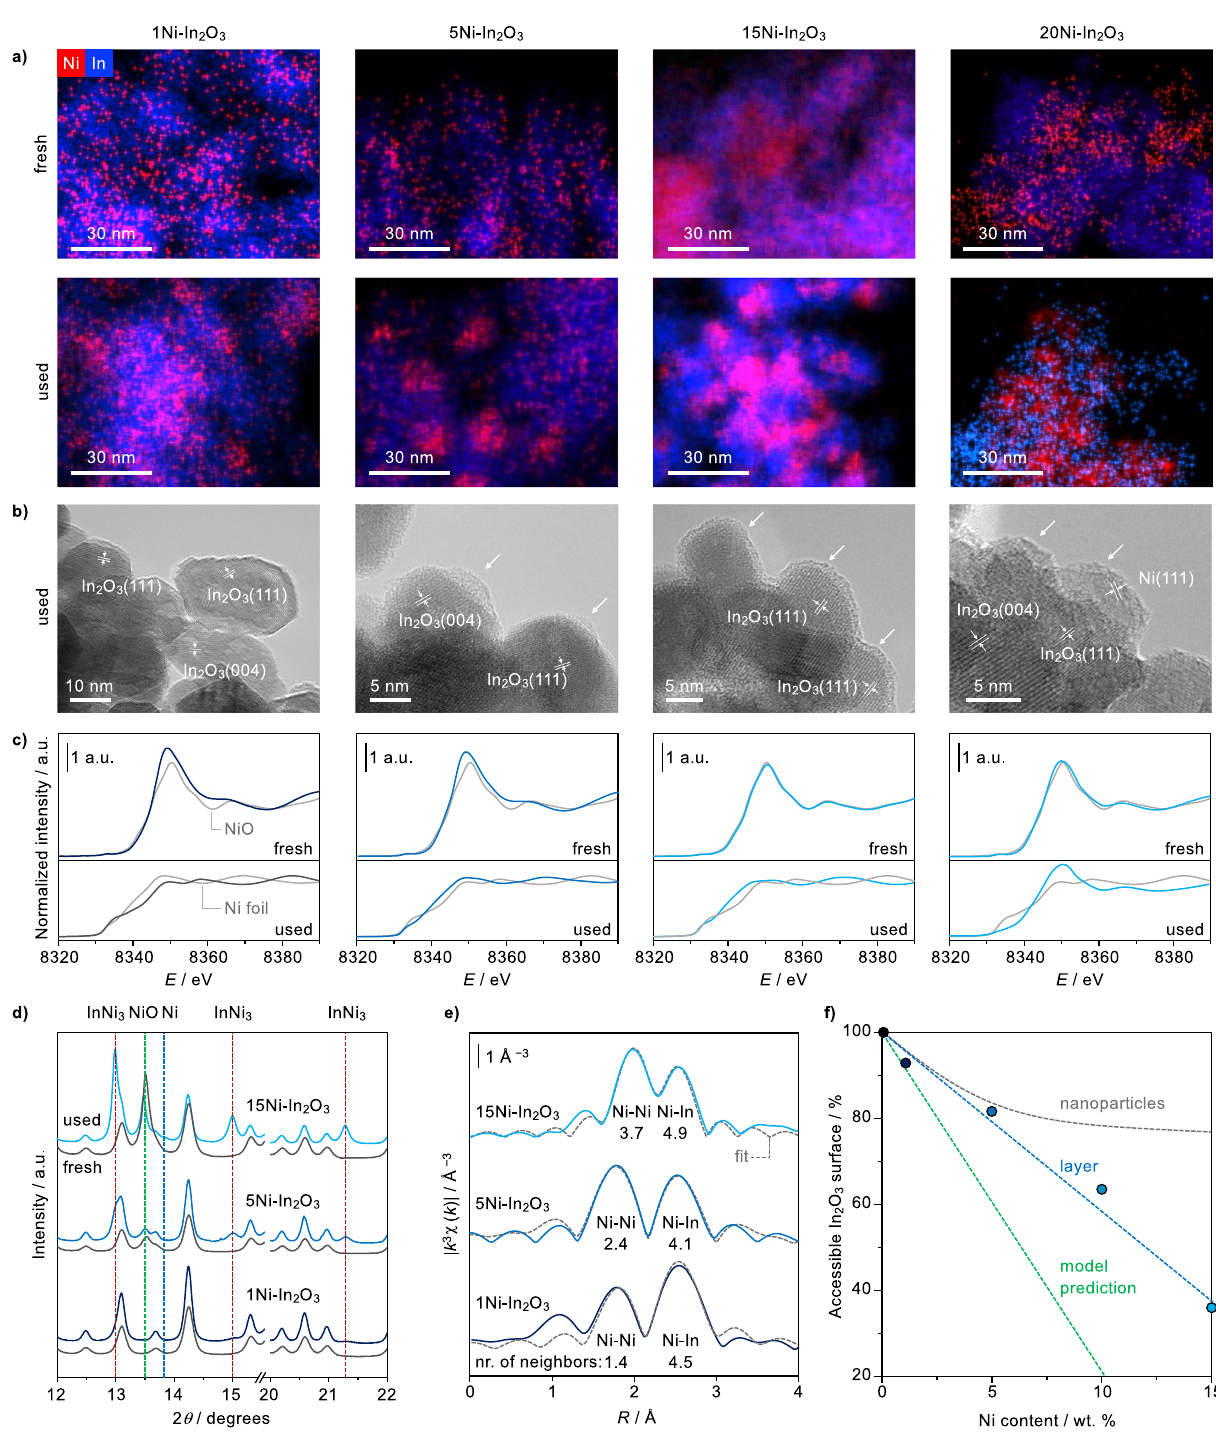
Fig. 3 Structural and electronic elucidation of nickel-promoted In 2 O 3 catalysts. a STEM-EDX maps of Ni-In 2 O 3 catalysts containing 1 – 20 wt.% Ni in fresh and used forms. b HRTEM images, with phases identi fi ed by fringe analysis and features of interest indicated, and c k -weighted Ni K-edge XANES, with spectra of NiO and metallic nickel serving as references, for the same used catalysts. d XRD patterns collected in monochromatic light and e EXAFS with model fi t and an indication of neighbors ’ number along a speci fi c scattering path for selected fresh and used samples. f Percentage of In 2 O 3 surface not covered by nickel as a function of the nominal nickel content, determined by volumetric CO 2 chemisorption. The qualitative trend respective to nanoparticle formation and the coverage predicted by DFT is indicated. a.u. = arbitrary High-resolution X-ray diffraction (XRD, Fig. 3d, Supplemen- nickel, respectively, in good agreement with the microscopy tary Fig. 4) measured in monochromatic light ( λ = 0.49292 Å) analyses. Alloy formation with indium shall be key to anchor the indicated that NiO, present in the fresh materials, reduced indeed intermetallic phase strongly to the catalyst surface, preventing forming InNi 3 alloys. Their average crystal size is <1, 2.7 ± 0.7, signi fi cant sintering. Only for 15Ni-In 2 O 3 , weak re fl ections and 7.3 ± 0.9 nm for the catalysts containing 1, 5, and 15 wt.% speci fi c to metallic nickel nanoparticles (ca. 1.2 nm) were also